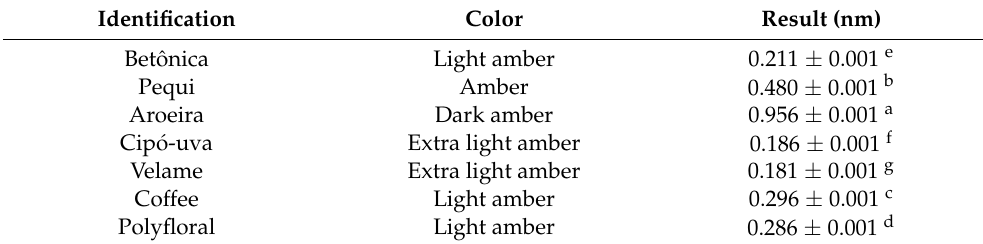
Table 3. Color shades of honeys (mean ± SD; n = 3).